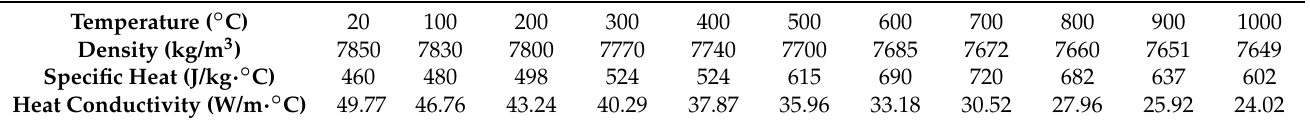
Table 2. Material properties of 1045